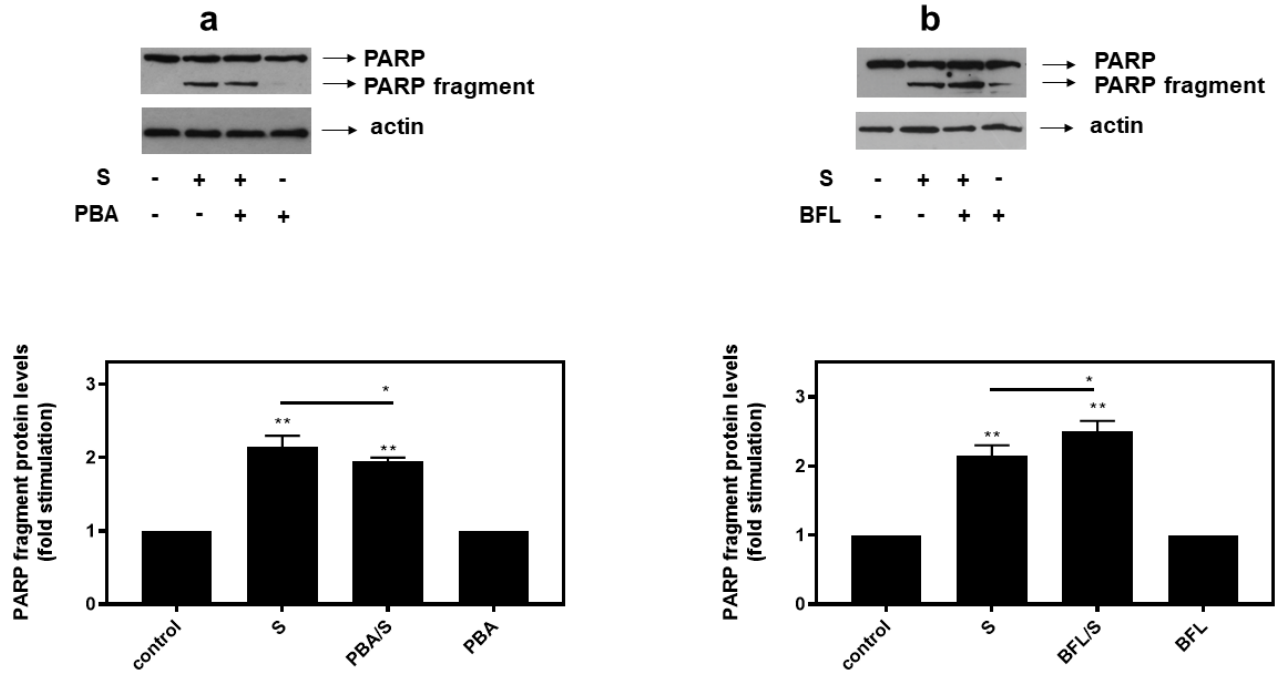
Figure 11. Opposite effects of PBA, an ER stress inhibitor and bafilomycin (BFL), an inhibitor of autophagy, on hyperosmotic-stress-induced PARP cleavage. H9c2 cells were left untreated (control) or were incubated with the inhibitors alone, or with the inhibitors followed by exposure to 0.5 M sorbitol in the presence of the inhibitors. Cell extracts (40 µ g/lane) were subjected to SDS-PAGE in 8% ( w / v ) polyacrylamide gels and immunoblotted with antibodies against endogenous levels of full-length PARP as well as the large 89 kDa PARP fragment (( a , b ) upper panels). Equal protein loading was verified by immunoblotting identical samples with a specific anti-actin antibody (( a , b ) bottom panels). Western blots are representative of at least three independent experiments with overlapping results. Immunoreactive bands were quantified by laser scanning densitometry and plotted (respective graphs). Results are means ± SEM for at least three independent experiments. ** p < 0.01 compared to control values; * p < 0.05 compared to sorbitol-treated cells in the absence of the